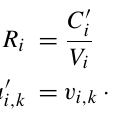
R. Figueiredo and M. Martina: Open building data in the development of exposure data sets the same at municipality level and grid-cell level.